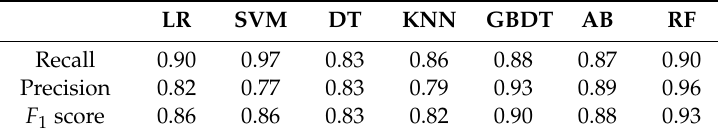
Table 4. The results of three criteria of di ff erent